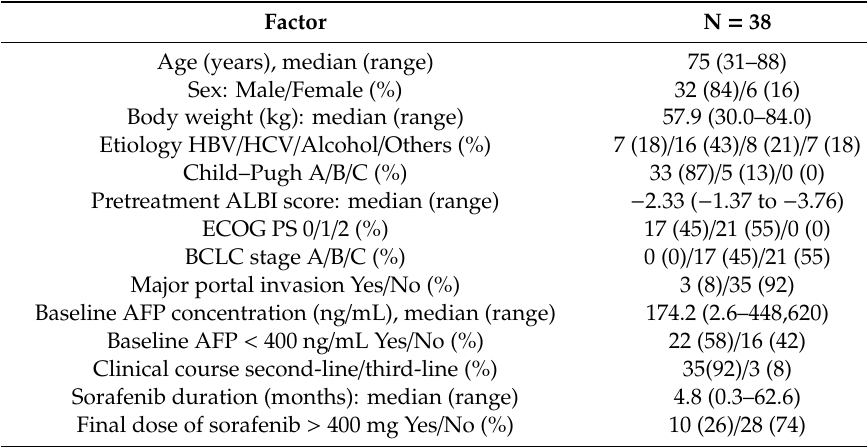
Table 1. Baseline characteristics of the